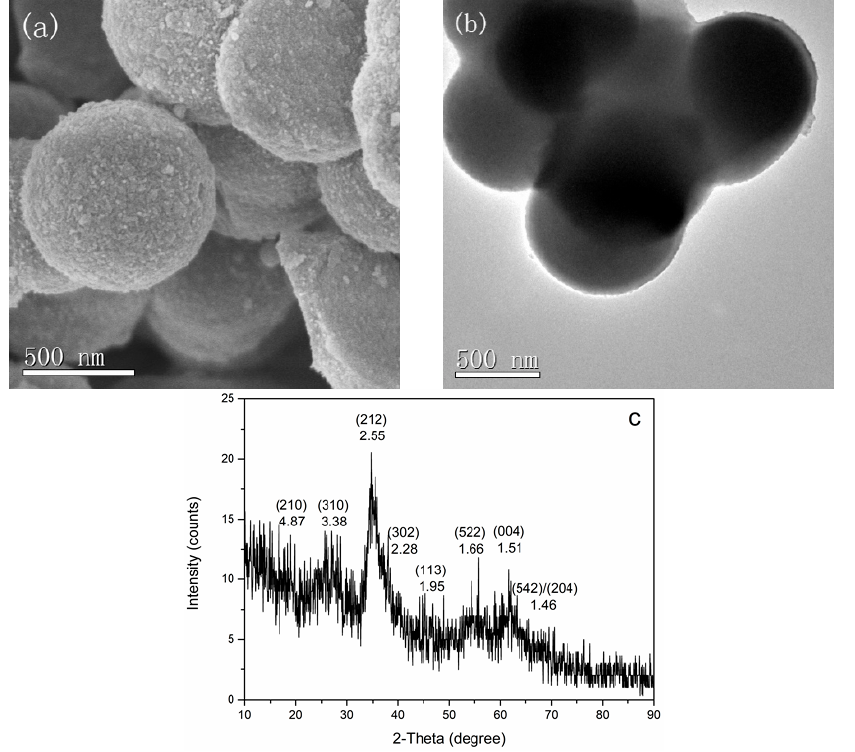
Figure 1. SEM ( a ); TEM ( b ); and XRD ( c ) analysis of synthesized schwertmannite.